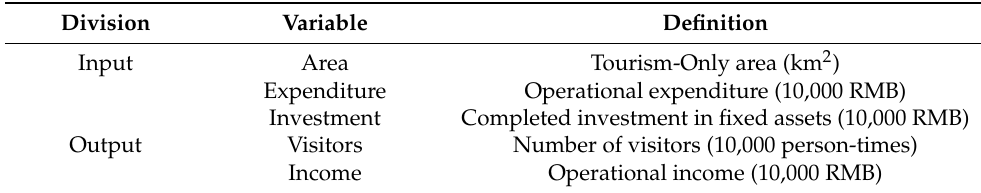
Table 1. Input and output indexes of NSA’s tourism